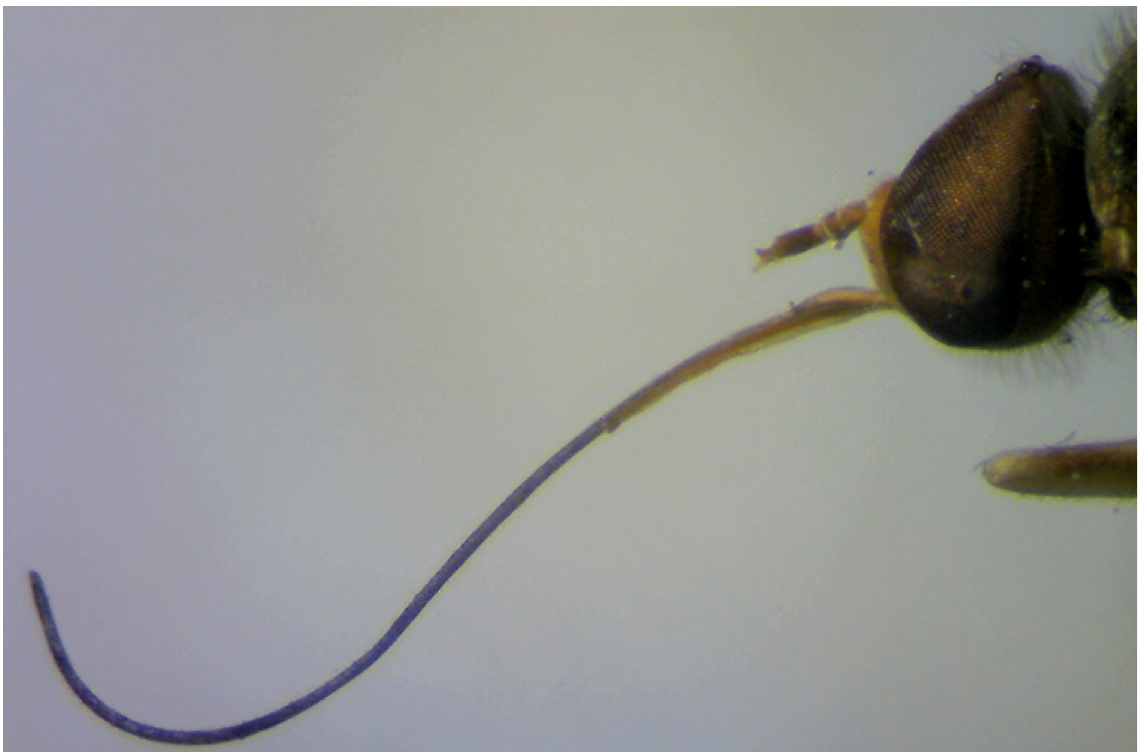
Fig. 2. Parageron longilingua sp. nov.,